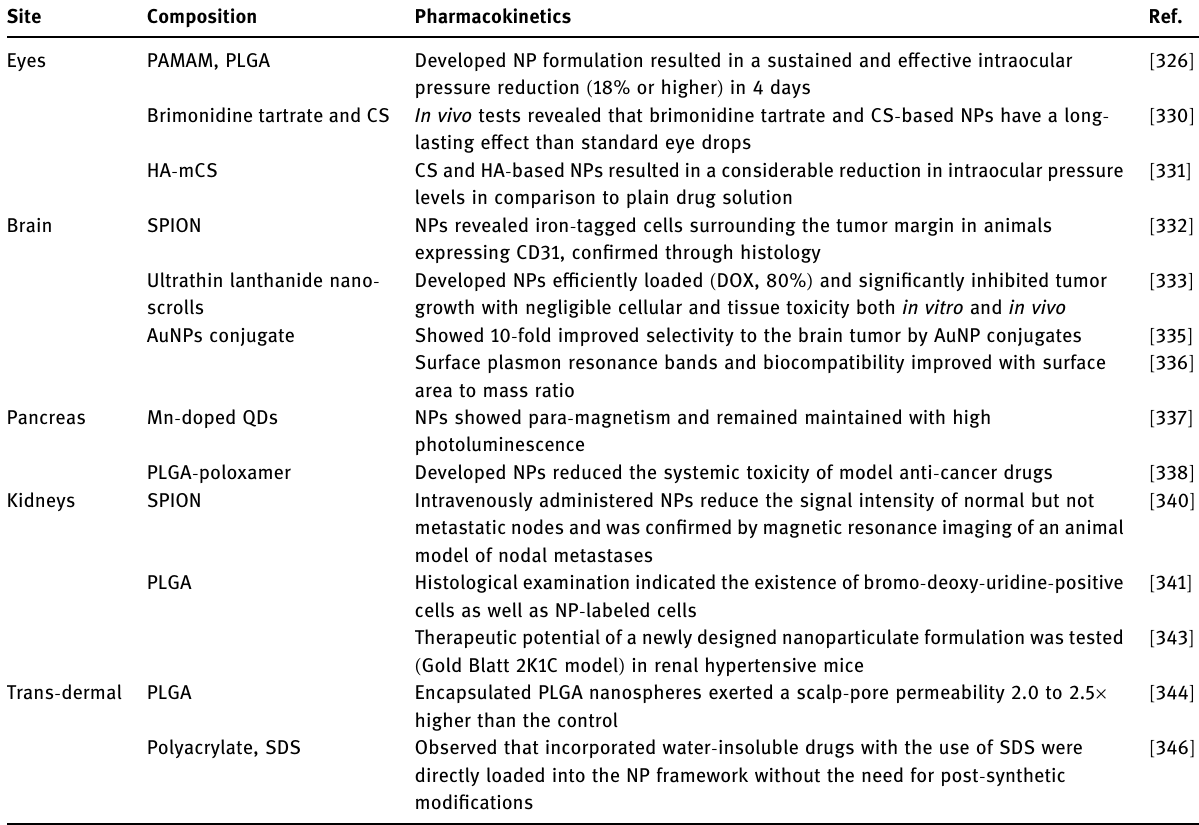
Table 4: NPs ’ carriers targeting of body organs and their pharmacokinetics speci fi city